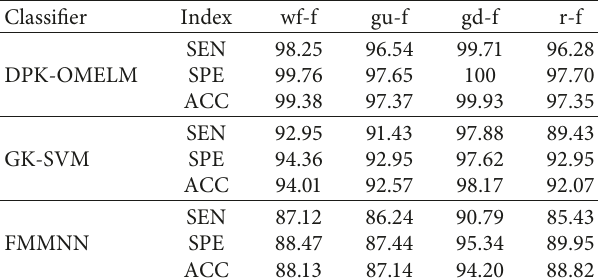
Table 9: SEN, SPE, and ACC of each fall activity under DPK- OMELM, GK-SVM, and FMMNN